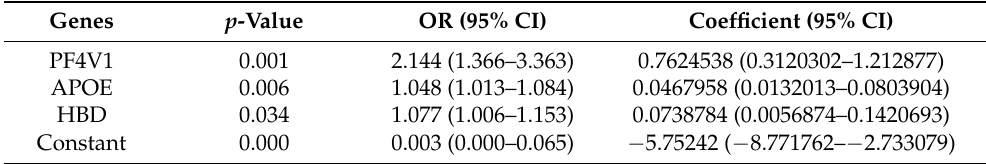
Table 4. Final EC patients vs. controls model: sensitivity/specificity plot for the resulting multi- Table 3. Final multivariate logistic regression model including only exosomes significantly associated variate logistic regression model for sensitivity levels higher than specificity levels. with the outcome EC patients vs. controls.